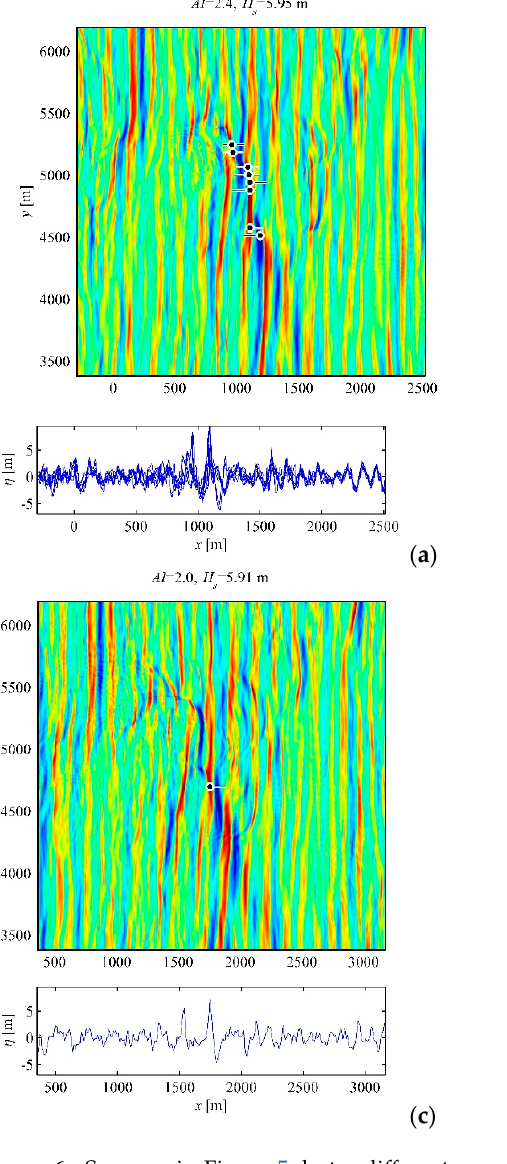
Figure 6. Same as in Figure 5, but a different event is shown from the series E 12 . The snapshots correspond to the following instants of time: ( a ) 529 s; ( b ) 559 s; ( c ) 609 s; and ( d ) 669 s.